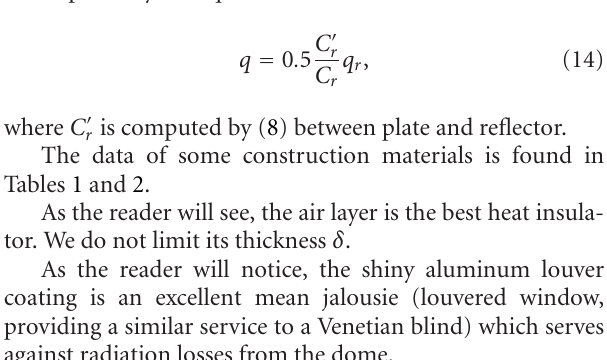
humidity. The computation of (16) is presented in Figure